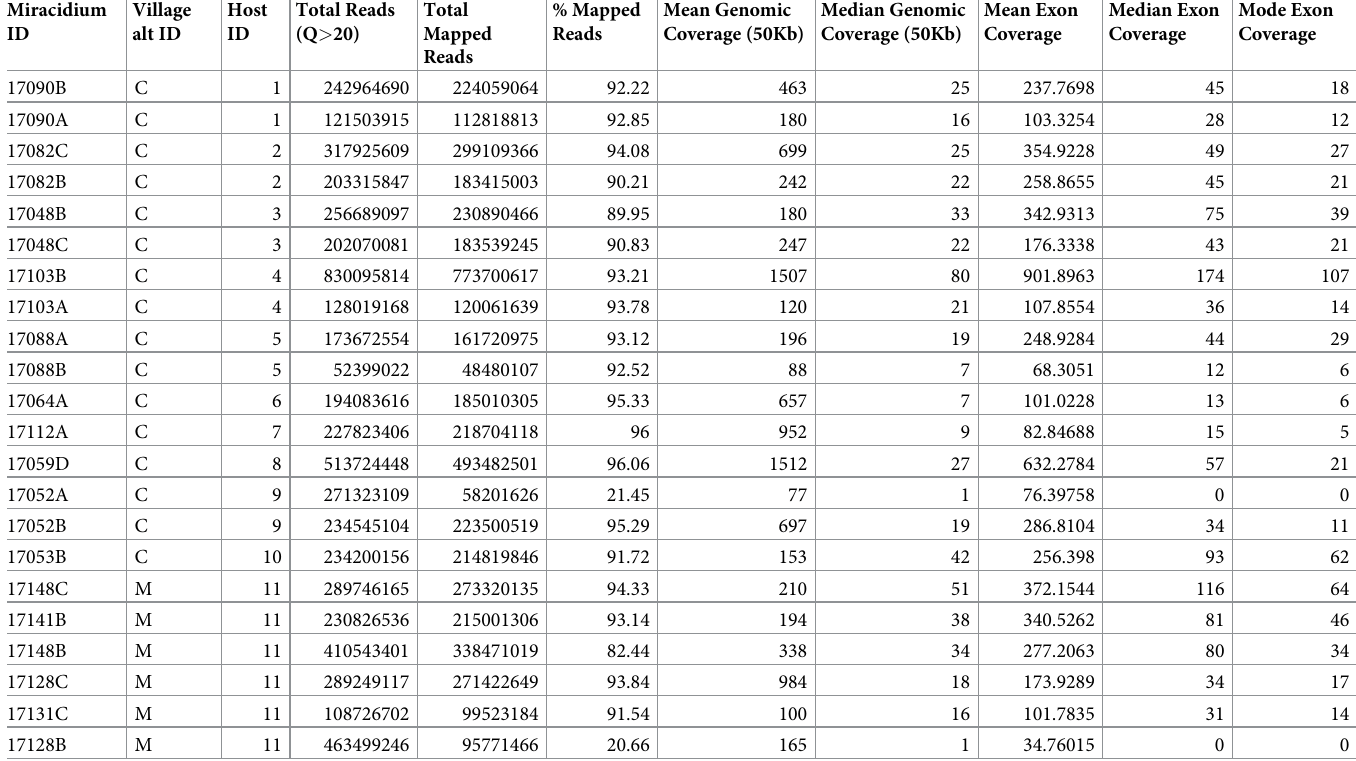
Table 2. Mapping and coverage statistics for each WGS sample. Total reads, proportion of mapped reads and central tendency statistics on exon coverage reported. Miracidium